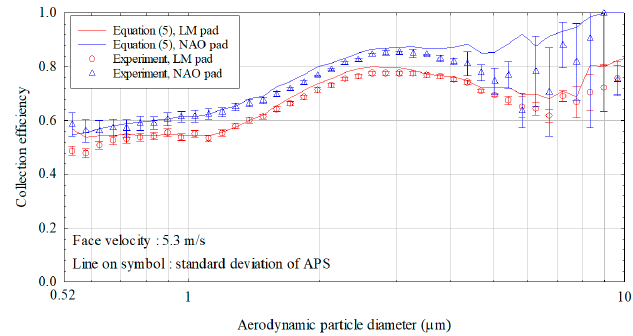
Figure 11. Size distributions of hybrid precipitator collection efficiencies for LM and NAO pads.